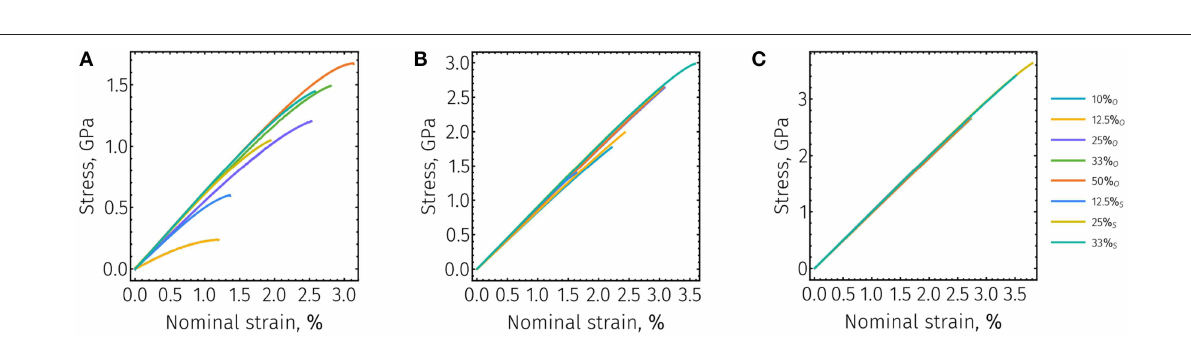
( L = 50 and L = 100 nm) failed without bond